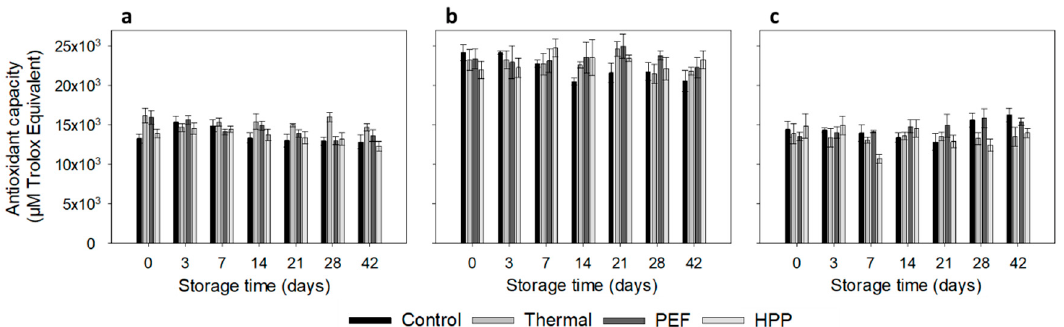
Figure 4. Antioxidant capacity via ORAC ( µ M Trolox Equivalent) for strawberry–water ( a ), strawberry–kale mix ( b ) and kale–water mix ( c ) during storage at 4 °C (n = 3).